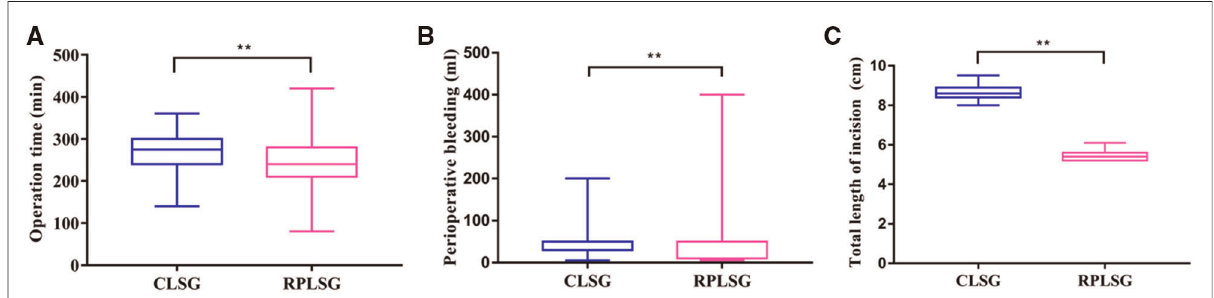
FIGURE 2 ( A ) operation time of different surgical methods; ( B ) effect of different surgical methods on perioperative bleeding; ( C ) effect of different surgical methods on total length of incision.